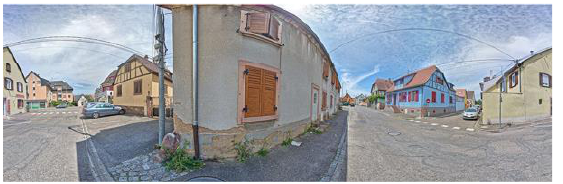
Figure 10a. Contemporary environment.